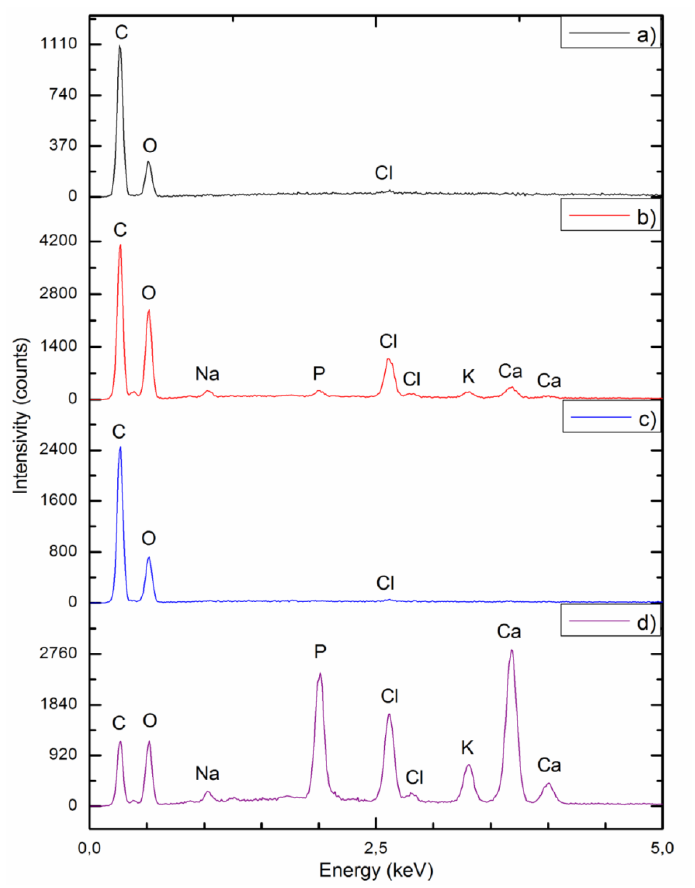
Figure 9. EDX spectra for ( a , b ) unmodified scaffolds before and after calcification, respectively; ( c , d ) scaffolds modified with gelatin and 5% HAp before and after calcification, respectively.